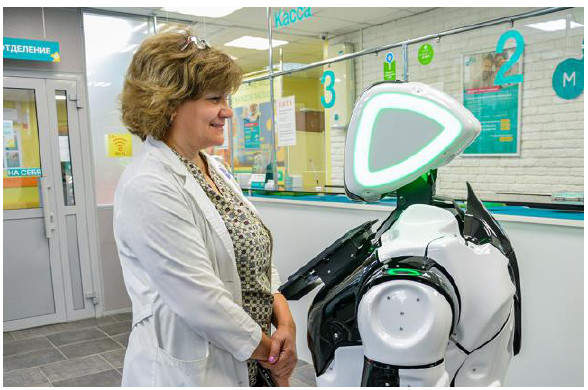
Figure 6. Anthropomorphic robot, Promobot Medical Assessor.